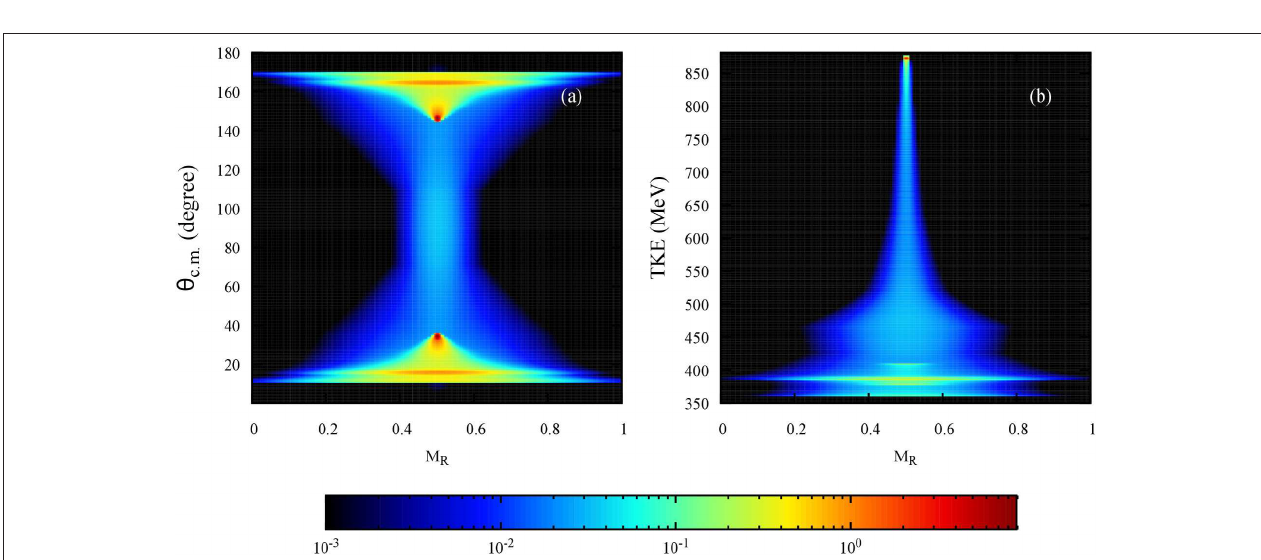
FIGURE 3 | Mass angle (a) and mass energy (b) distributions predicted by TDRPA for the 176 Yb + 176 Yb collision in the side-side orientation at E c.m. = 880 MeV. Units are in millibarns per degree (a) and millibarns per MeV (b)